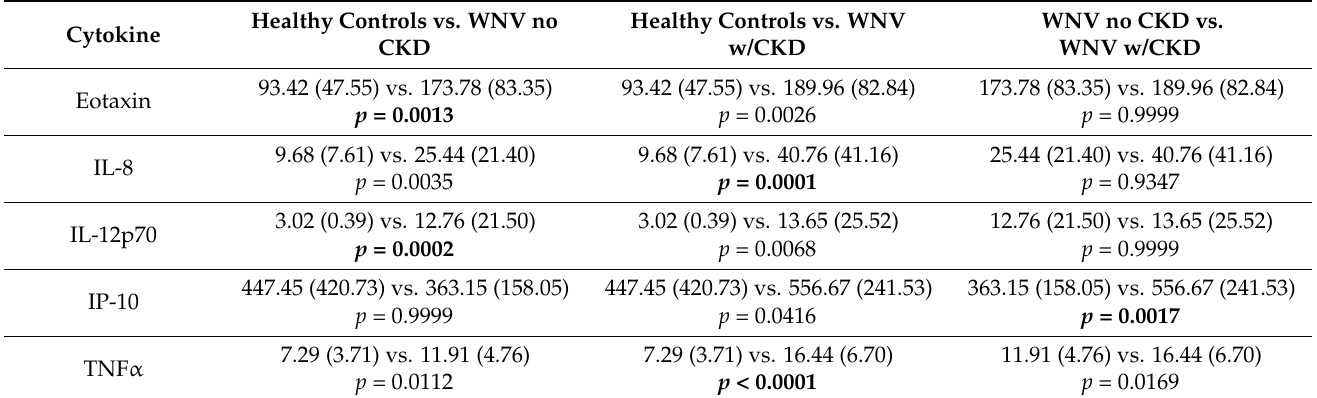
Table 4. Dunn’s test for inter-group post hoc comparison of cytokine